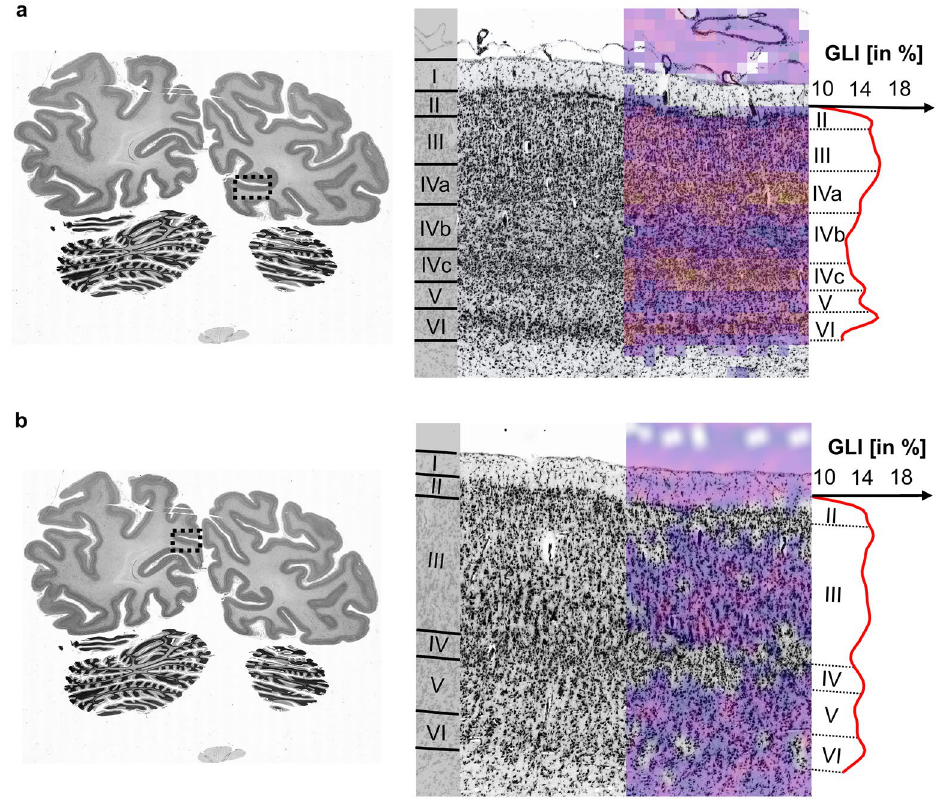
Figure 6. Second level filter activations from network layer 5 of the hOc1 ( a ) and network layer eight of the hOc2 ( b ) CNN . Big images on the right show the microscopically magnified regions of interest for cortical area hOc1 ( a ) and hOc2 ( b ) depicted by boxes on the left images (section 1021). They display cell-body stained histological images with the corresponding GLI profiles generated at this position. Roman numerals I to VI indicate cortical layers. Arabic letters indicate cortical sublayers. Superimposed characteristic filter activations show specific activations to cell-dense cortical layers of cortical area hOc1 ( a ) and cell-sparse cortical layers of cortical area hOc2 ( b